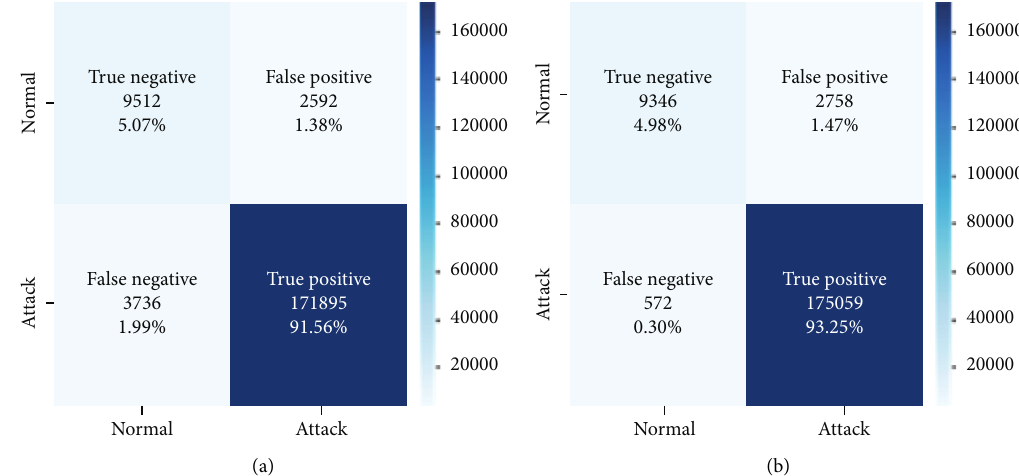
Figure 10: Confusion matrix of (a) the convolution neural network (CNN) model and (b) the long short-term memory (LSTM) model.